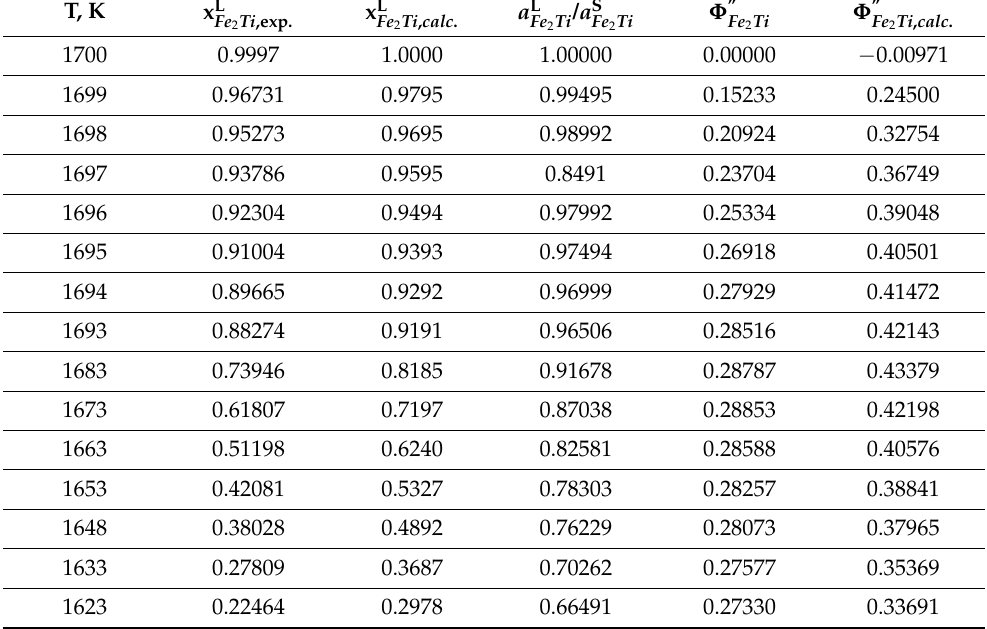
Table 2. The comparative analysis of the experimental and calculated data of Fe 2 Ti crystallization along the monovariant phase equilibrium line for the Fe 2 Ti-Fe system. T, K x L Fe 2 Ti ,exp.